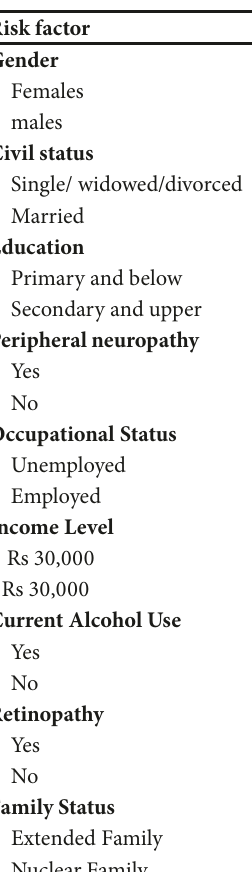
Table 3: Bivariate analysis using chi square showing the risk factors associated with depression.